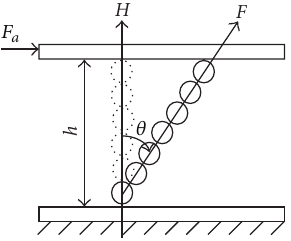
Figure 5: The analysis mode of shear yield